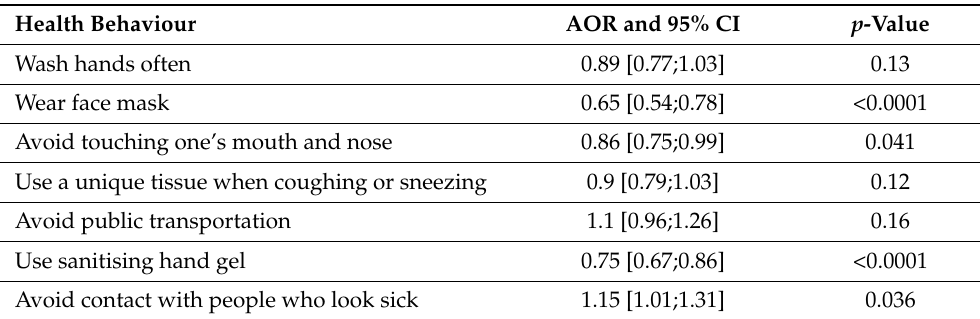
Table 5. Association between unrealistic optimism and adoption of health-protective behaviours recommended to control the risk of infection by SARS-CoV-2: odds ratio and 95% CI (adjusted for sex, age, education, and country), p